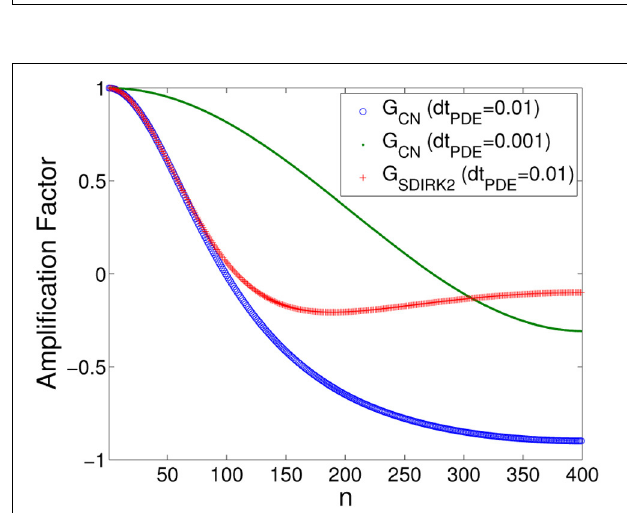
FIGURE 9 | CN and SDIRK2 amplification factors from Equations (9) and (10) for Scenario